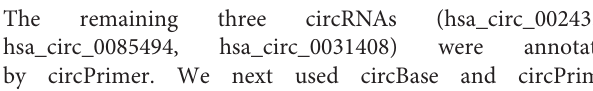
Selection of Screened CircRNAs | LogFC| ≥ 1 and P < 0.05 were set as hub circRNA screened criteria. The top 15 circRNAs were identified as candidate circRNAs, including